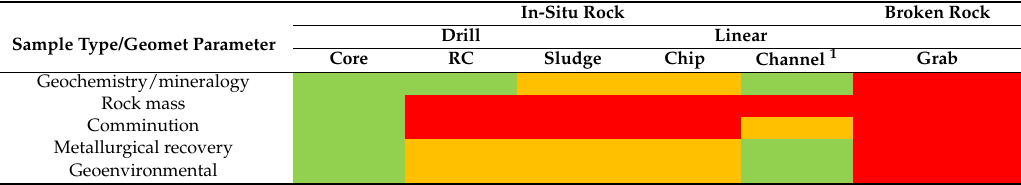
Table 25. Potential contribution of grade control samples to geometallurgical ore control. Assumes best practice sample collection for all samples. Green: applicable; Orange: potentially; Red: